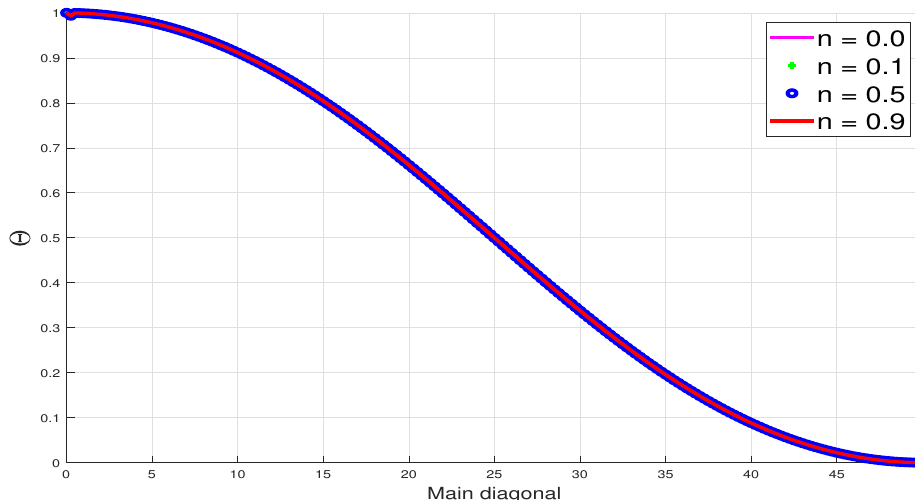
Figure 13. Temperature dependence on n at t = 5.